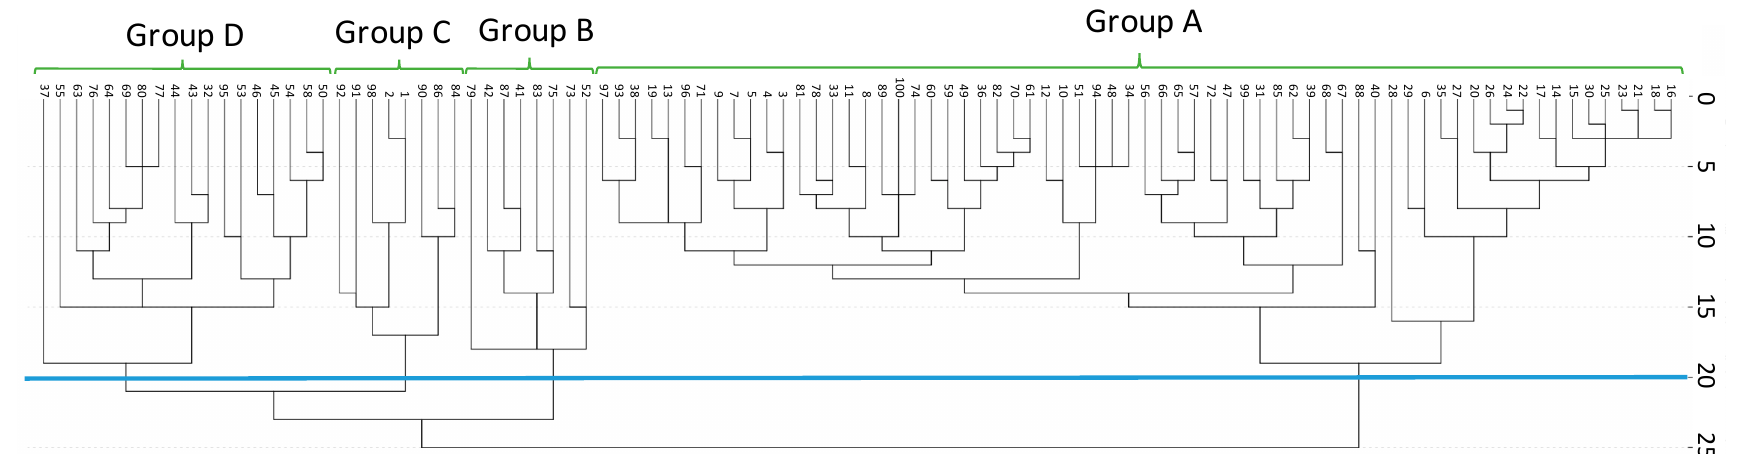
Figure 1. UPGMA dendrogram of the chemical similarity among the plant individuals within the study population ( n = 100).